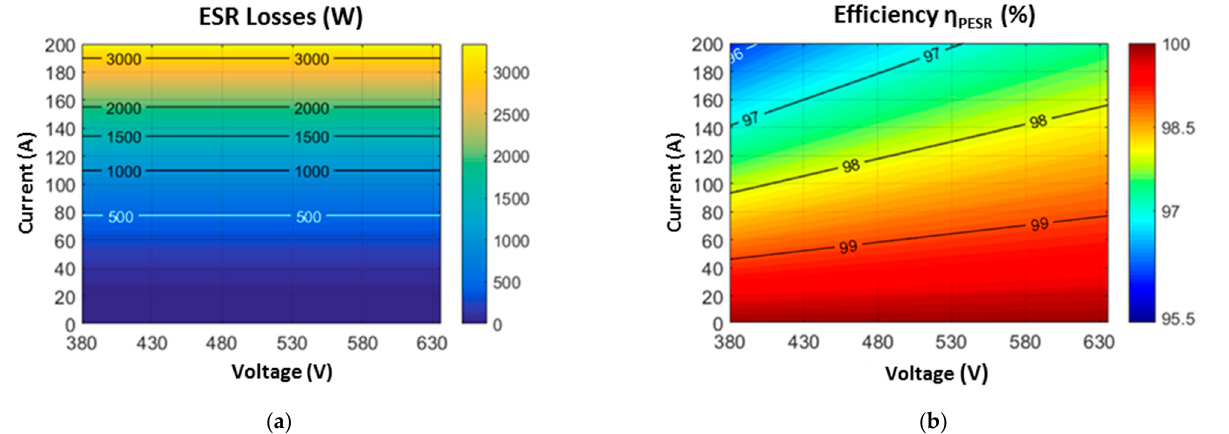
Figure 4. ( a ) Power losses in the equivalent series resistance (ESR) as a function of the current and voltage measured in the SC cabinet and ( b ) efficiency map of the module due to ESR losses.